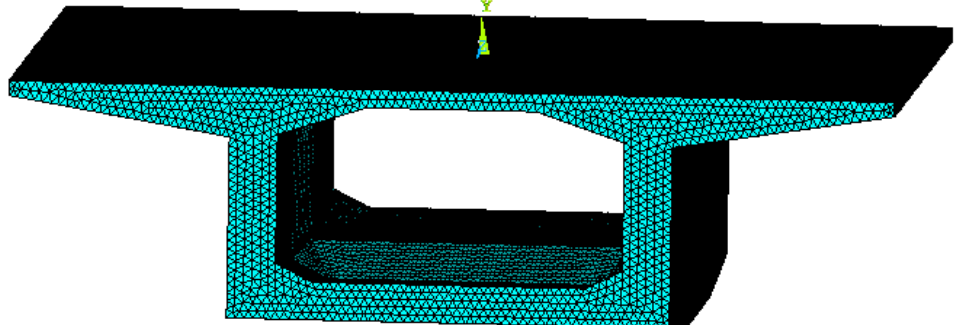
Figure 4. Numerical model of a 0-block of Huangsha Harbor Bridge.